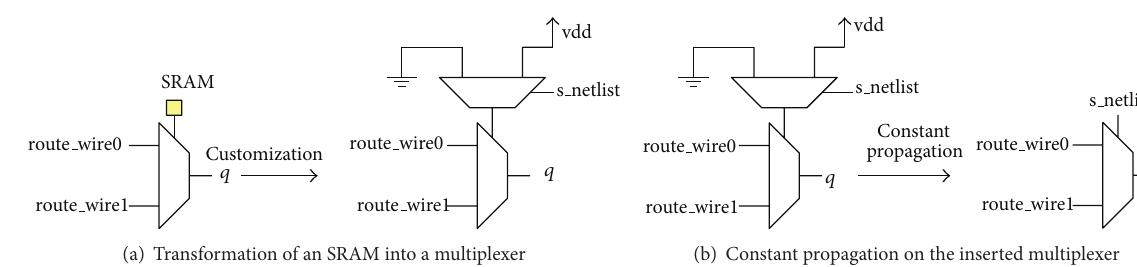
Figure 9: Hard coding of an SRAM in the routing